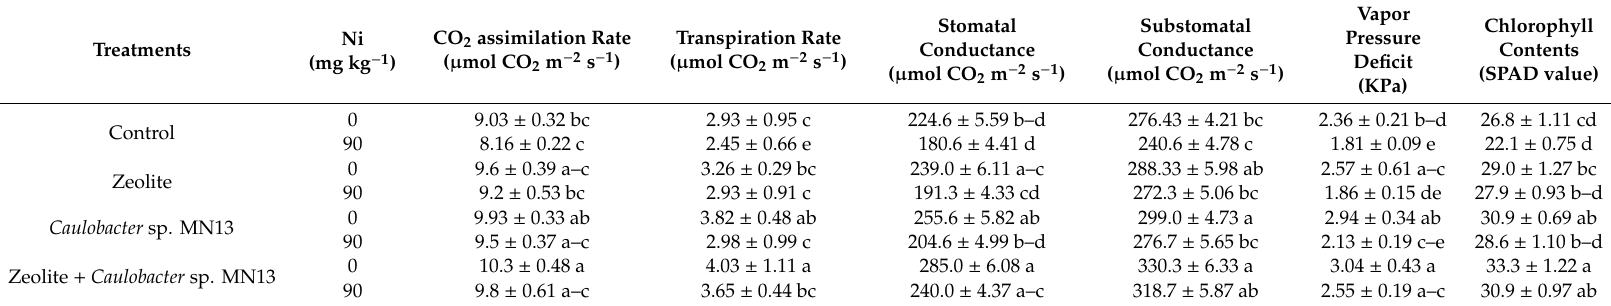
Table 3. E ff ect of Caulobacter sp. MN13 and zeolite on physiological parameters of sesame in normal and Ni contaminated soil.